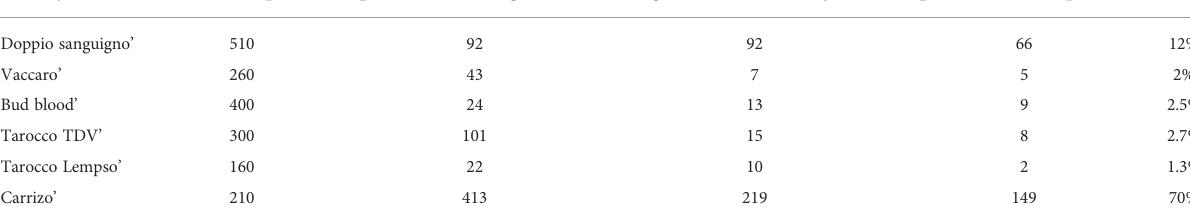
TABLE 1 Transformation ef fi ciency of ‘ Doppio sanguigno ’ , ‘ Vaccaro ’ , ‘ Tarocco TDV ’ , ‘ Tarocco Lempso ’ , ‘ Bud Blood ’ sweet oranges, and ‘ Carrizo ’ citrange.